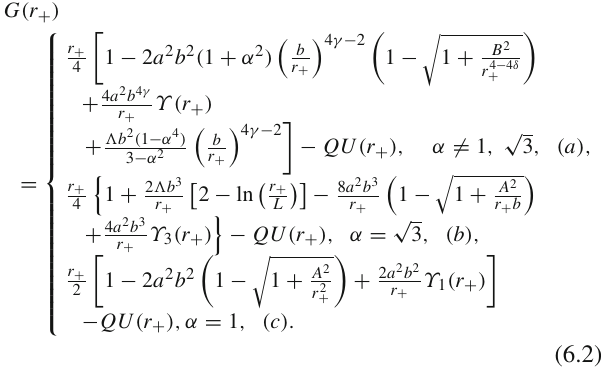
The plots show that: (i) For α < 1 the Ricci scalar has